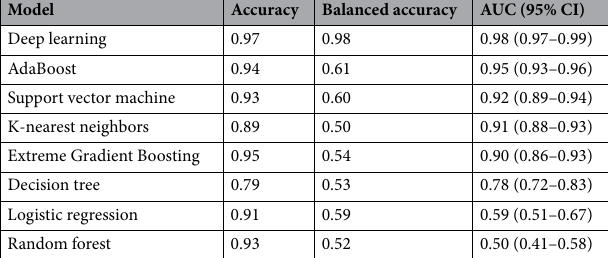
Table 2. Comparison among machine learning and deep learning